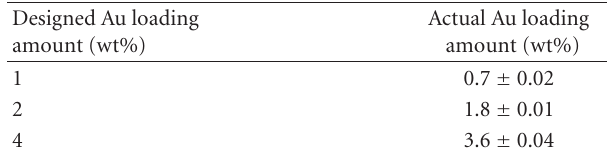
Table 1: The contents of gold in Au / TiO 2 composites prepared by DP